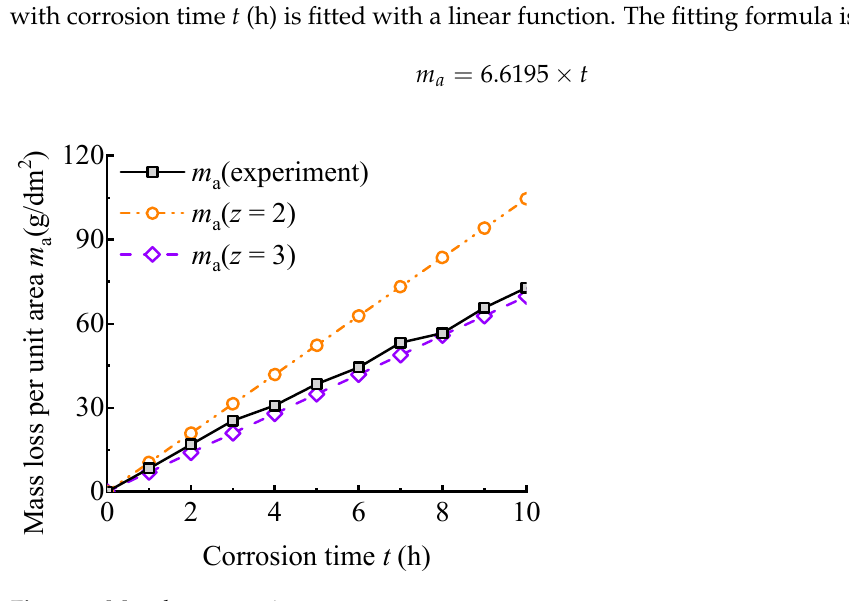
Figure 2. Mass loss per unit area.